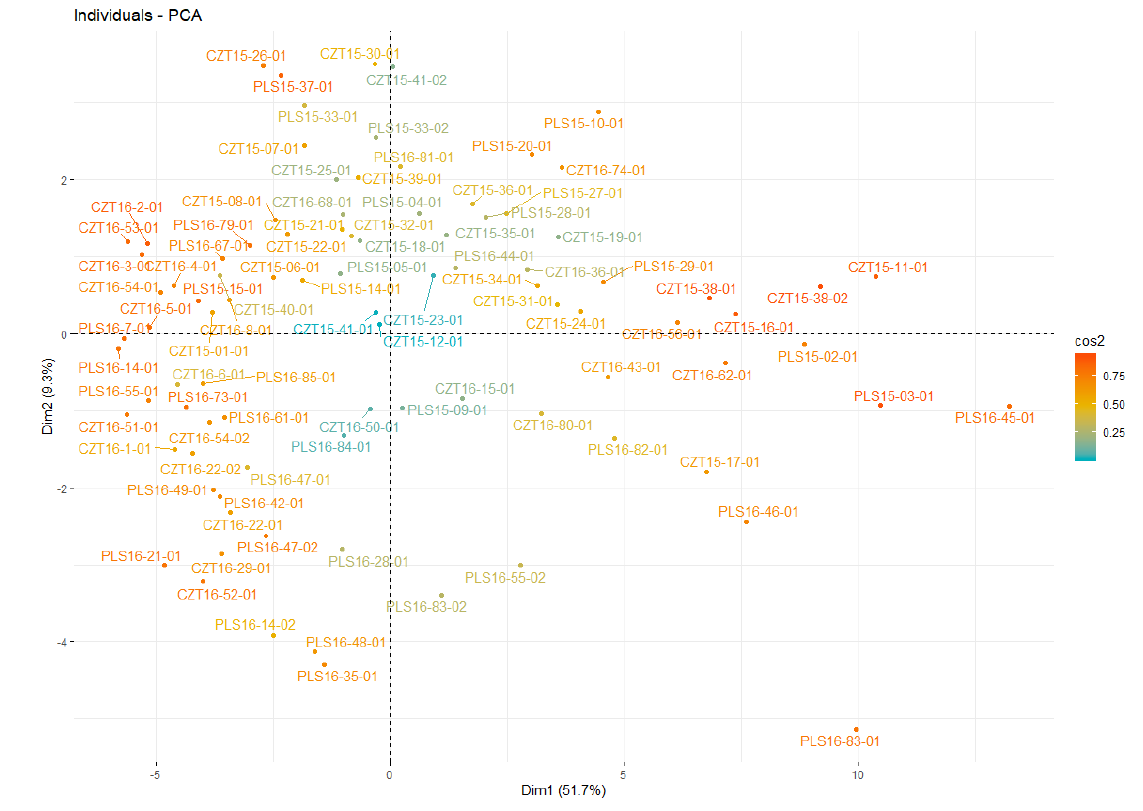
Figure 5. Scatterplot of the component score of individual sampling